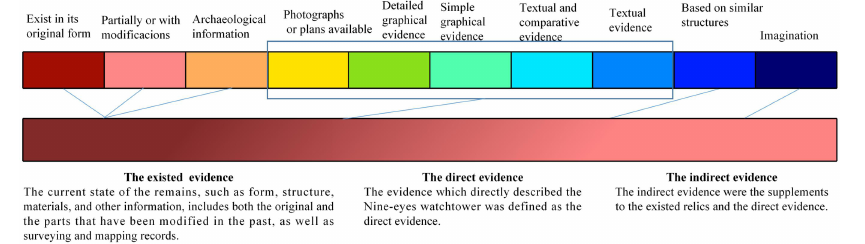
Figure 2. The classification of the evidence scale.